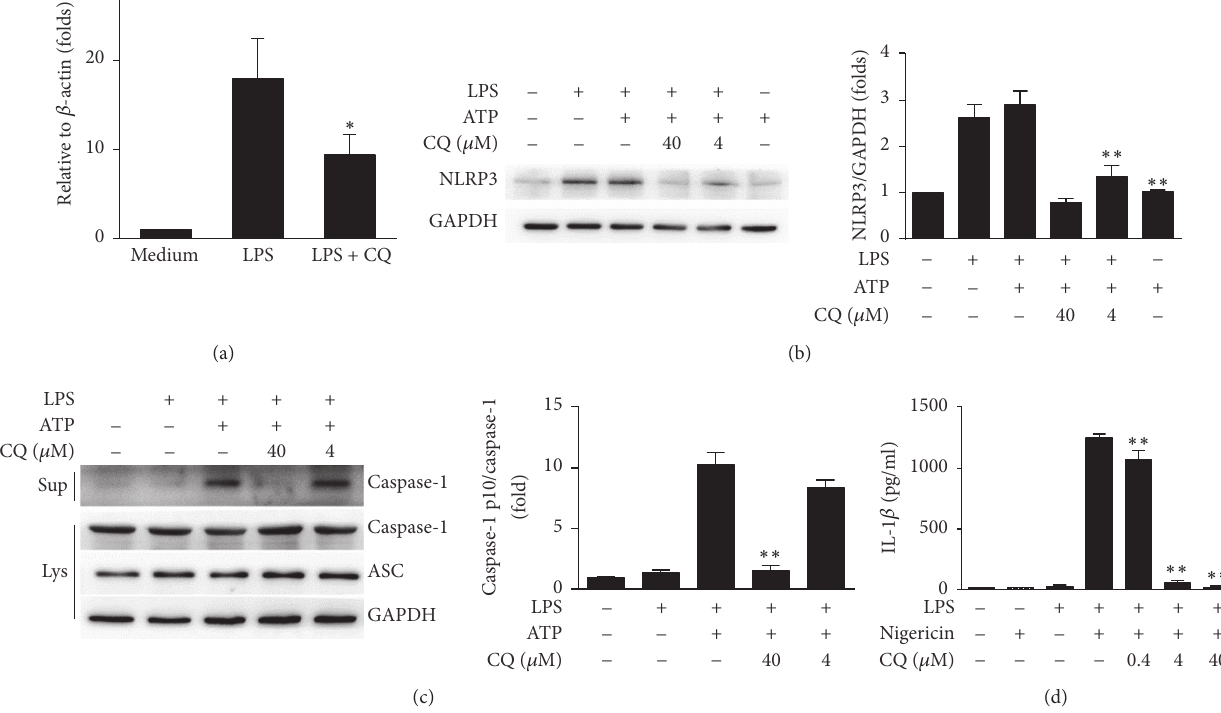
Figure 4: CQ dampens NLRP3 inflammasome activation. BMDMs were pretreated with CQ (4, 40 𝜇 M) for 1h and then stimulated with LPS (100ng/ml) for 4 h and ATP (2mM) for an additional 1h. (a) Nlrp3 mRNA expression was measured by qRT-PCR. (b) NLRP3 and GAPDH were measured in cell lysates by western blot. (c) Western blot analysis of cleaved caspase-1 (p10) in culture supernatants (Sup) or of procaspase-1, ASC, and tubulin in cell lysates (Lys). (d) BMDMs were pretreated with CQ at the indicated concentration for 1h and then stimulated with LPS (100ng/ml) for 4 h and nigericin (10 𝜇 M) for 30min. Production of mature IL-1 𝛽 in supernatants was measured by ELISA. Data are shown as means ± SEM; ∗ 𝑃 < 0.05 , ∗∗ 𝑃 < 0.01 versus LPS plus ATP